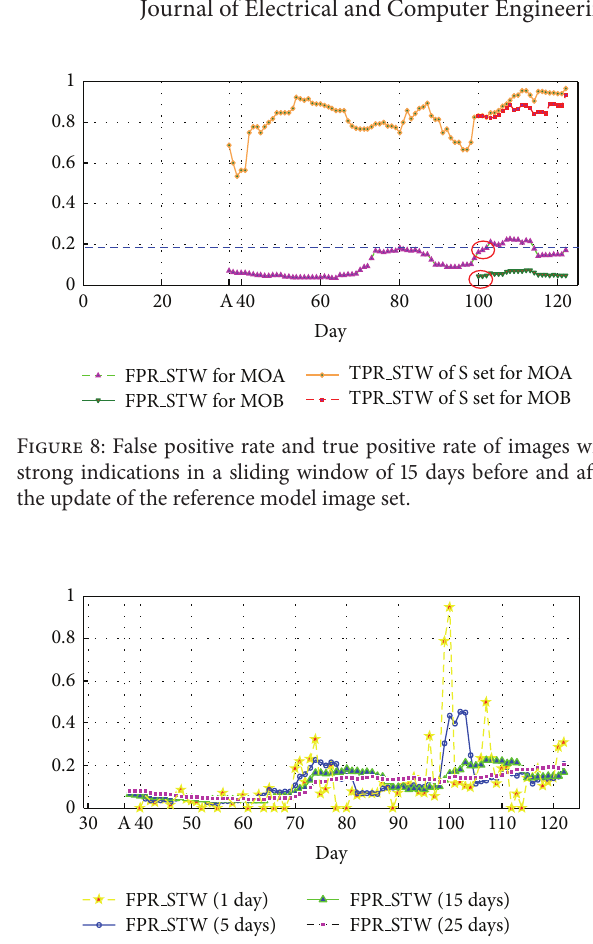
Figure 9: FPR in different sliding-time windows for